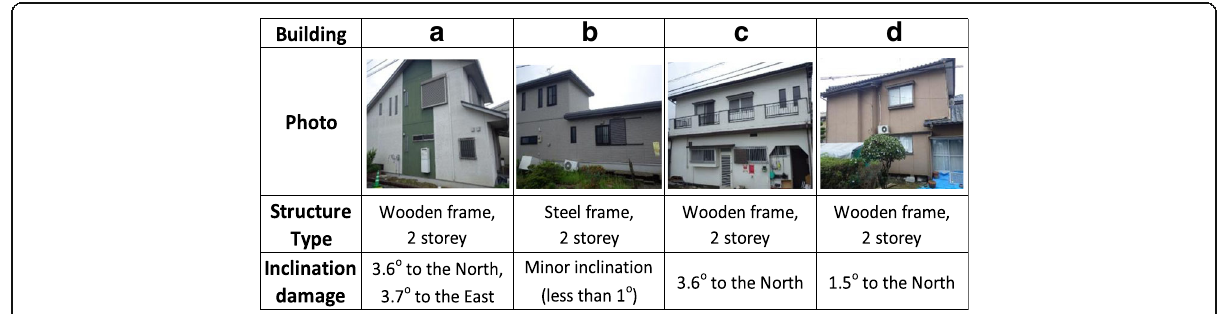
Fig. 11 The summary of the structure type and damage level (Buildings A, B, C and D in Fig. 8) in Akitsu